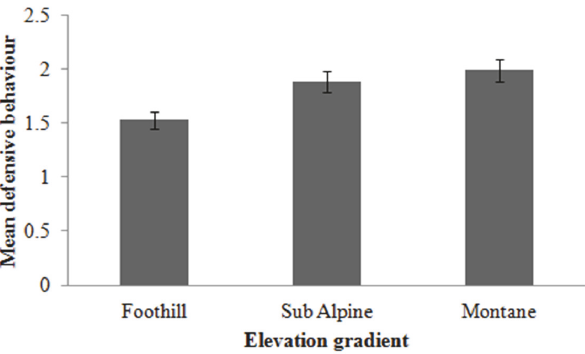
Figure 4: Comparison of the defensive behaviour of the honeybees according to elevationgradient. The defensive behaviourwas scored as 1 = very defensive; 2 = moderate; and 3 = less